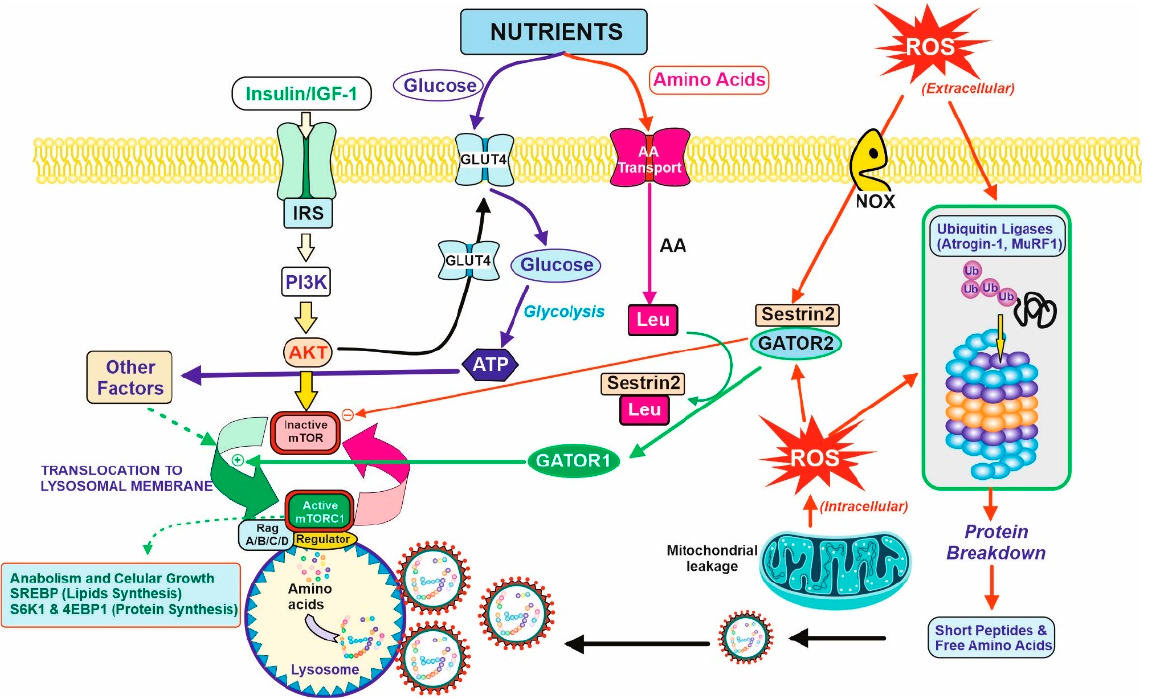
Figure 2. Balance between anabolic and catabolic signals in the myocyte. Nutrients and growth factors induce mTOR activation for protein synthesis. However, oxidative stress is caused by extracellular or intracellular ROS and accelerated protein degradation by the ubiquitin–proteasome system (by the induction of atrogenic genes. They are ubiquitin ligases (Atrogin-1 and MuRF1) that induce the formation of the protective protein Sestrin2 and diminish protein synthesis (right figure). Nutrients supply glucose for energy production (ATP) and amino acids for protein synthesis or catabolism, producing further energy and nitrogenous toxic compounds, mostly urea. Due to the last process, CKD patients should have limitations in terms of protein intake, and therefore, limits the bioavailability of amino acids. In this regard, Leu is partially important. Leu is needed for the activation of mTOR activity in the presence of Sestrin2 protein due to the oxidative stress situation. The binding of Leu to Sestrin2 promotes the action of GATOR1 for mTOR activation, although translocation to lysosomal membrane and other factors are required for complete activation and triggering anabolic processes (lipids and protein synthesis, left on the figure). CKD patients should have a counterbalance between the degradative and anabolic signals in the myocyte to avoid lean muscle loss with the minimal amount of protein to avoid excessive urea formation.